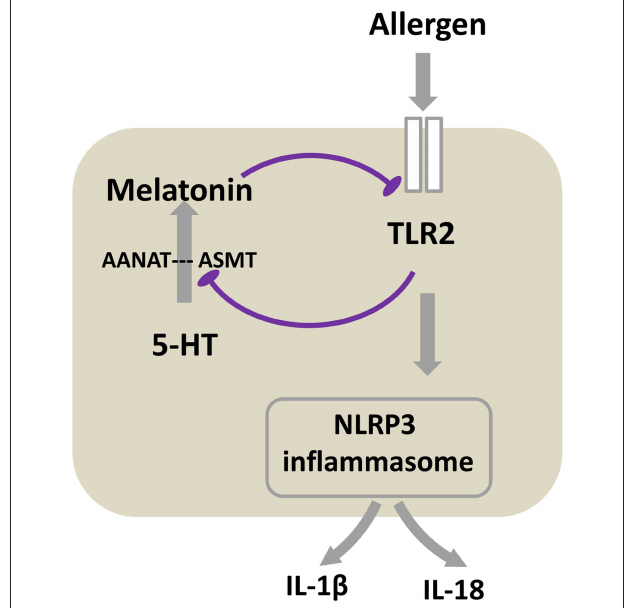
FIGURE 7 | Proposed schematic of the mechanism that TLR2-melatonin feedback loop regulates the activation of NLRP3 inflammasome in allergic airway inflammation. After TLR2 is activated by allergen, it subsequently induces NLRP3 inflammasome activation. Meanwhile, TLR2 inhibits the expression of melatonin synthetase ASMT, accordingly blocks 5-HT converting to melatonin, ultimately leading to the decreased level of melatonin. This inhibition of melatonin synthesis results in the loss of its inhibitory effect on the TLR2 signaling. The result of the cycle is the persistent of allergic airway